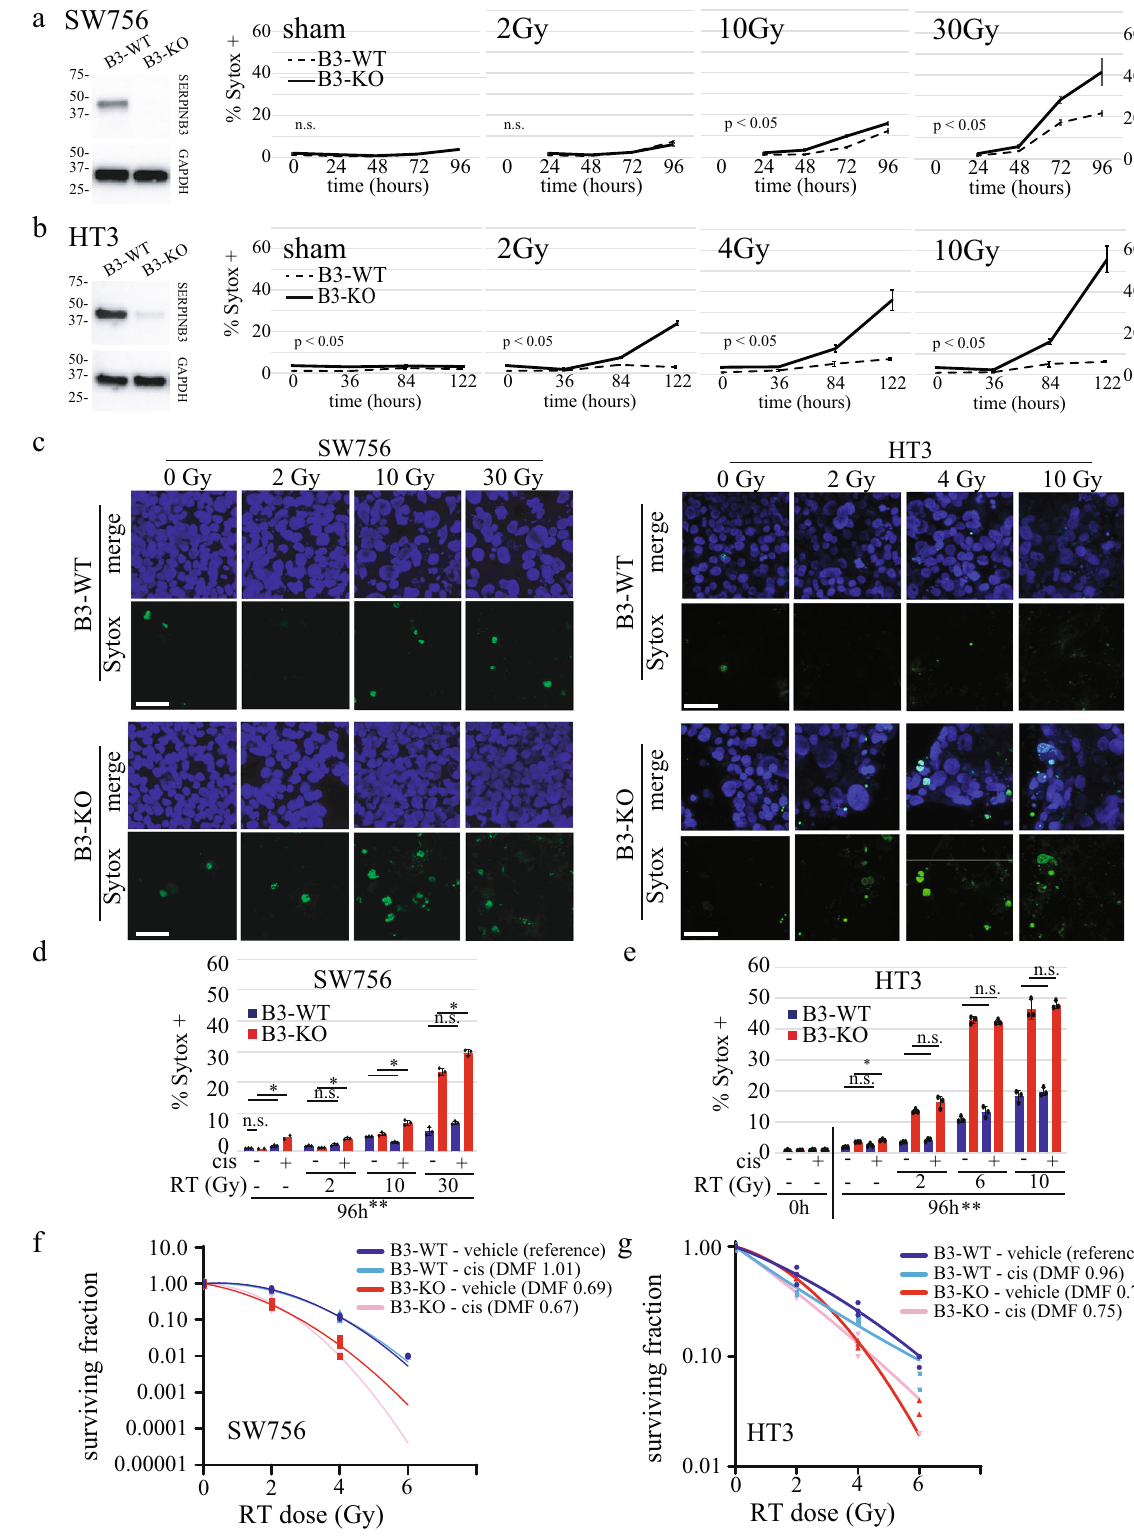
death (Fig. 1d – e) and clonogenic survival (Fig. 1f – g) was greater than the radiosensitizing effect seen with cisplatin chemotherapy. Dose modifying factors (DMF, determined as the ratio of the dose resulting in 10% surviving fraction compared to control untreated) was greater for single gene B3 -KO compared to cisplatin in both SW756 (DMF 0.69 for B3-KO versus 1.01 for